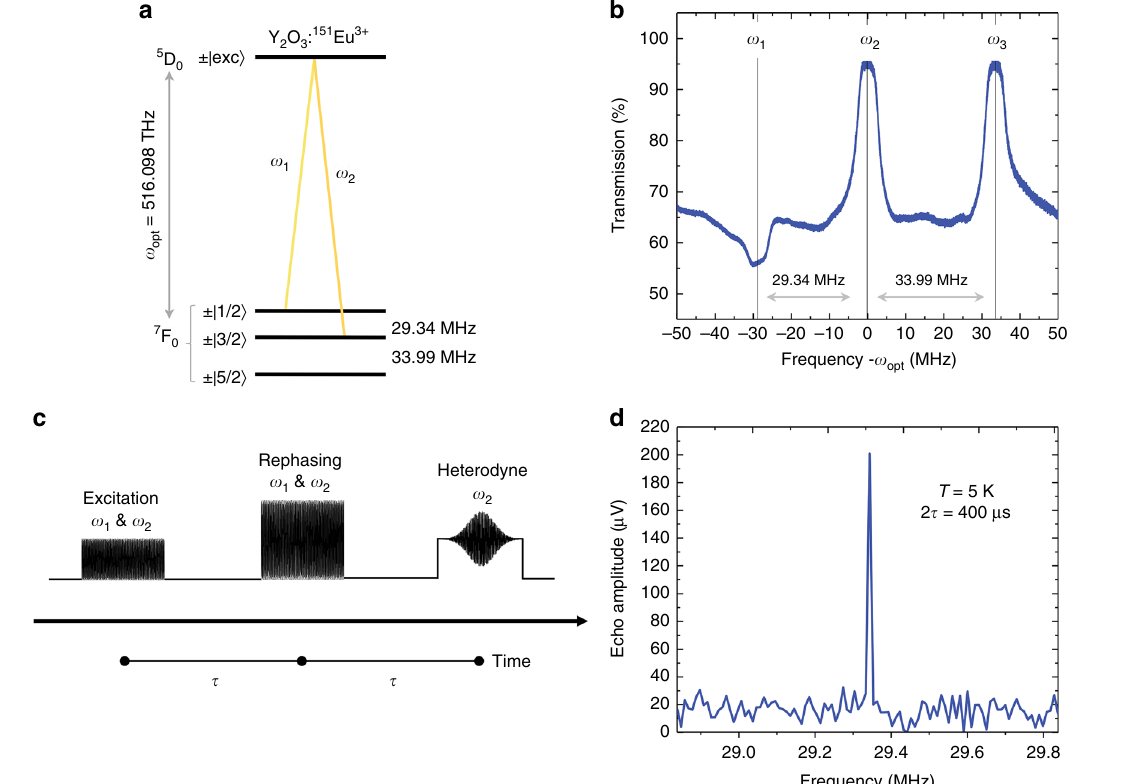
Fig. 1 All-optical nuclear spin coherence investigation in 151 Eu 3 + -doped Y 2 O 3 nanoparticles. a 151 Eu 3 + ground-state hyper fi ne structure in Y 2 O 3 . Two-color laser pulses (at ω 1 and ω 2 frequencies) resonant with the 7 F 0 → 5 D 0 transition at 580.883 nm create coherent states between the ± 1 = 2 ij and ± 3 = 2 ij nuclear spin levels. ± exc ij represents the excited state hyper fi ne levels. b Optical transmission spectrum after optical pumping. Ground-state population initialization to ± 1 = 2 ij corresponds to a lower transmission at ω 1 . High transmission (~95%) at 0 ( ω 2 ) and 33.99 MHz ( ω 3 ) evidences ef fi cient population depletion in the ± 3 = 2 ij and ± 5 = 2 ij levels. ω opt = 516.098 THz (580.883 nm). c All-optical spin-echo sequence with heterodyne detection. Each sequence is preceded by optical pumping and followed by chirped pulses to reset the spin population to equilibrium. d Fast Fourier transform of the heterodyne signal revealing the spin echo at 29.34